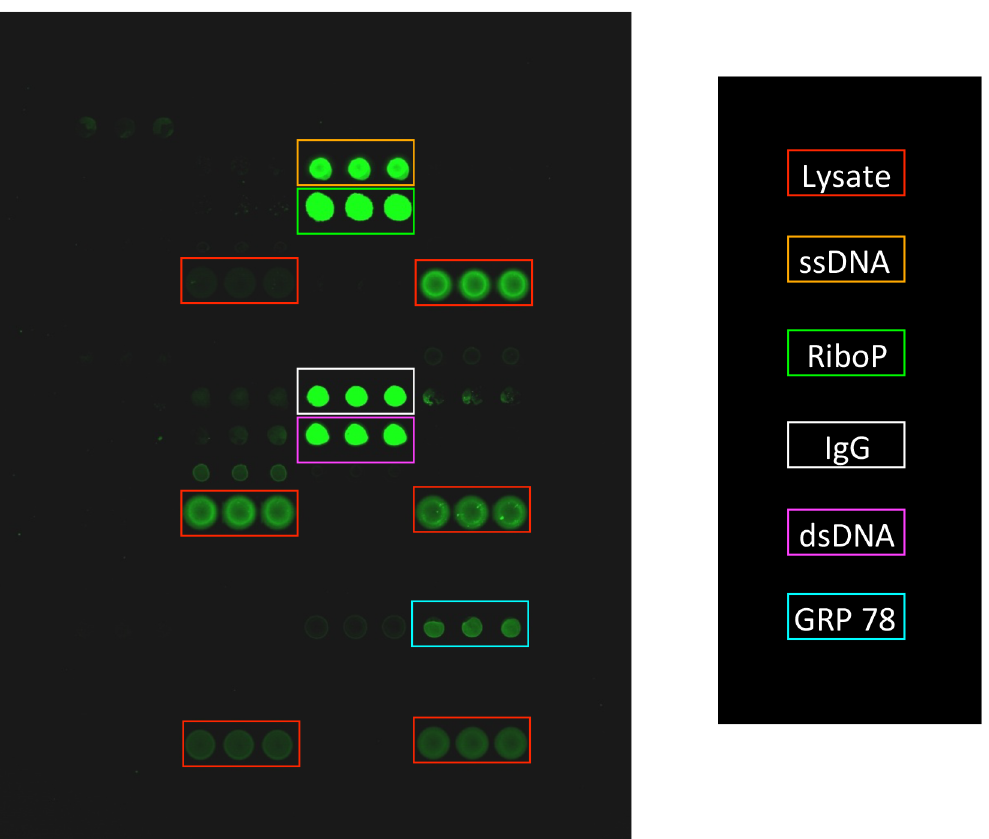
Fig 1. Scanned image of an antigen microarray probed with positive control serum. Array features were spotted in triplicate and then probed with serum with known reactivity to ribosomal phosphoprotein P0. A single Cy3-labelled secondary antibody that detects human IgG/IgM was used. Identity of antigens is indicated by the legend. IgG that is spotted onto the array is detected by the secondary antibody. Multiple reactivities are detected with the positive control serum including ribosomal phosphoprotein P0 (RiboP) (green box), single-stranded DNA (ssDNA) (orange box), double stranded DNA (dsDNA) (purple box) and the heat shock protein GRP78 (blue box). Red boxes indicate placement of six different cellular lysates. Array features are approximately 500 mm in diameter.